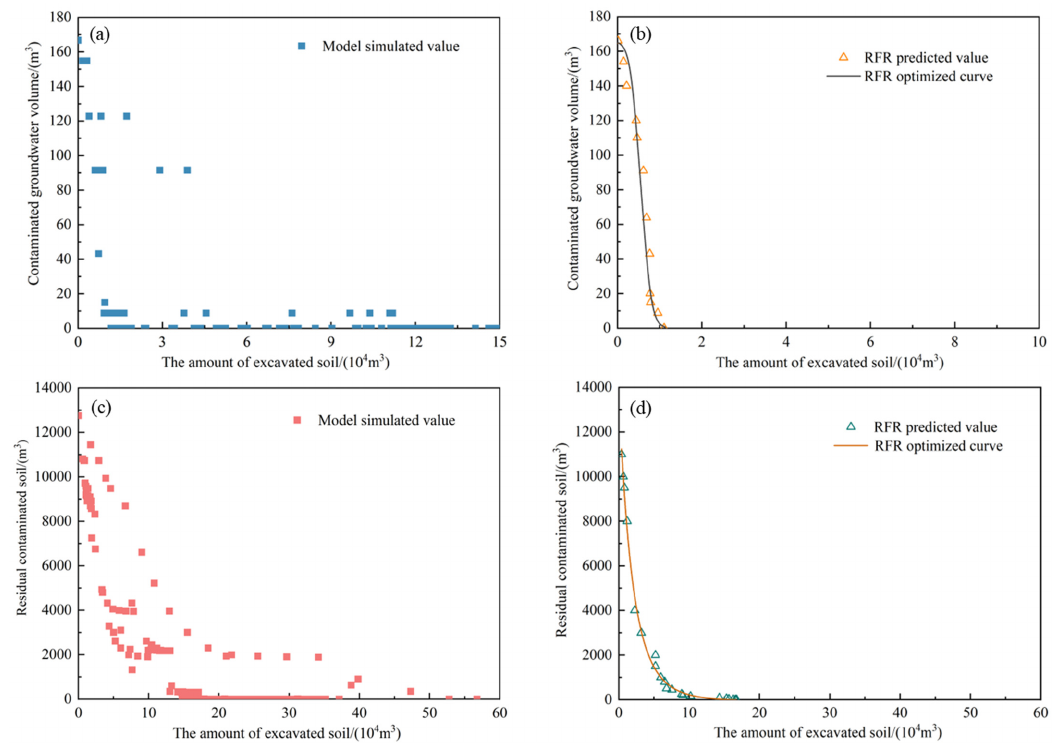
Figure 7. The simulated results of the volume of the contaminated groundwater ( a ) and the volume of residual contaminated soil ( c ) as a function of volume the excavated contaminated soil. Symbols are the results from the process-based model. Plot ( b ) and plot ( d ) are the optimized profile from the RFR model between the volume of excavated contaminated soil and the minimal volumes of contaminated groundwater ( b ) and the residual contaminated soil ( d ).